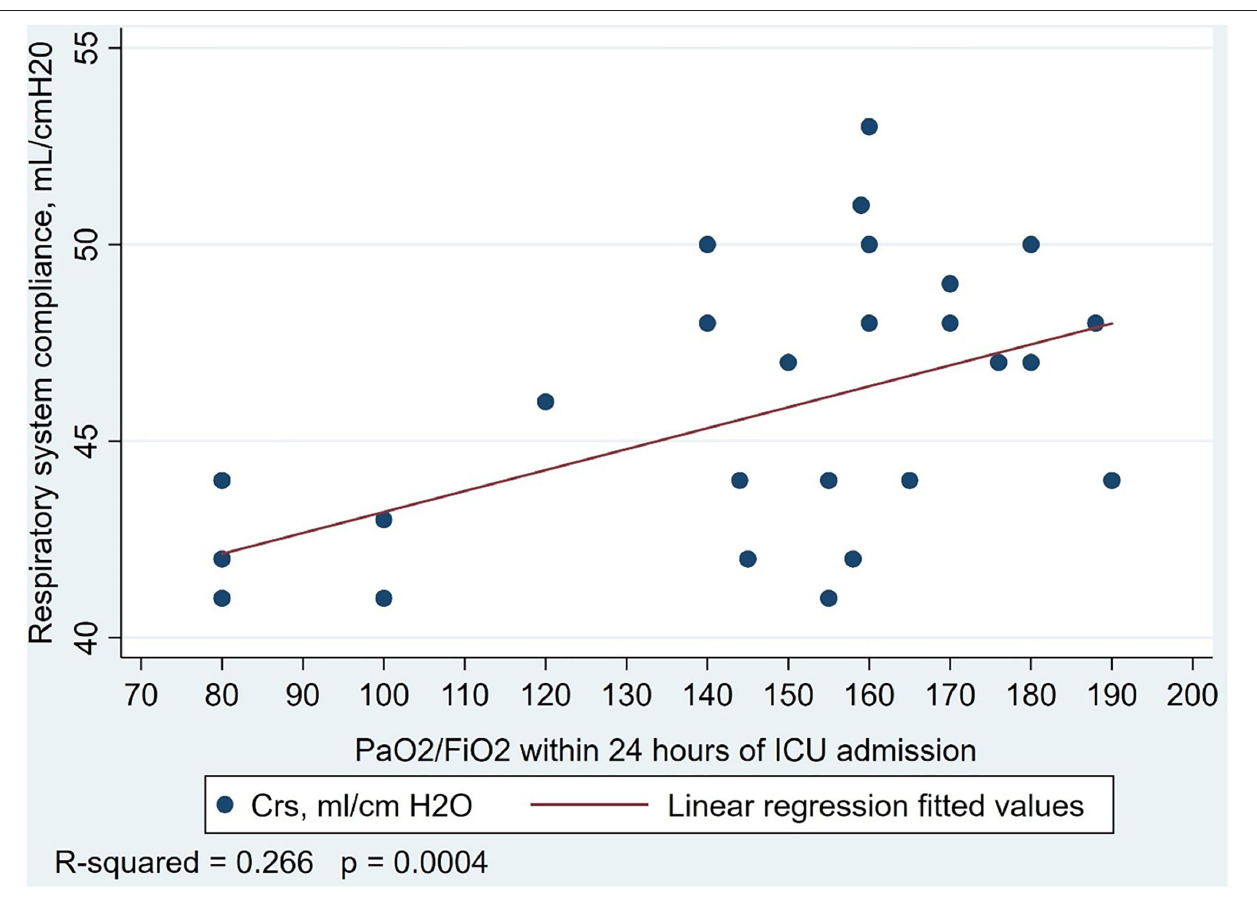
FIGURE 1 | Association between respiratory system compliance and PaO2/FIO2 ratio in 43 patients with acute respiratory distress syndrome from etiologies not related to COVID-19. Linear regression model R2 = 0.266, P < 0.001.